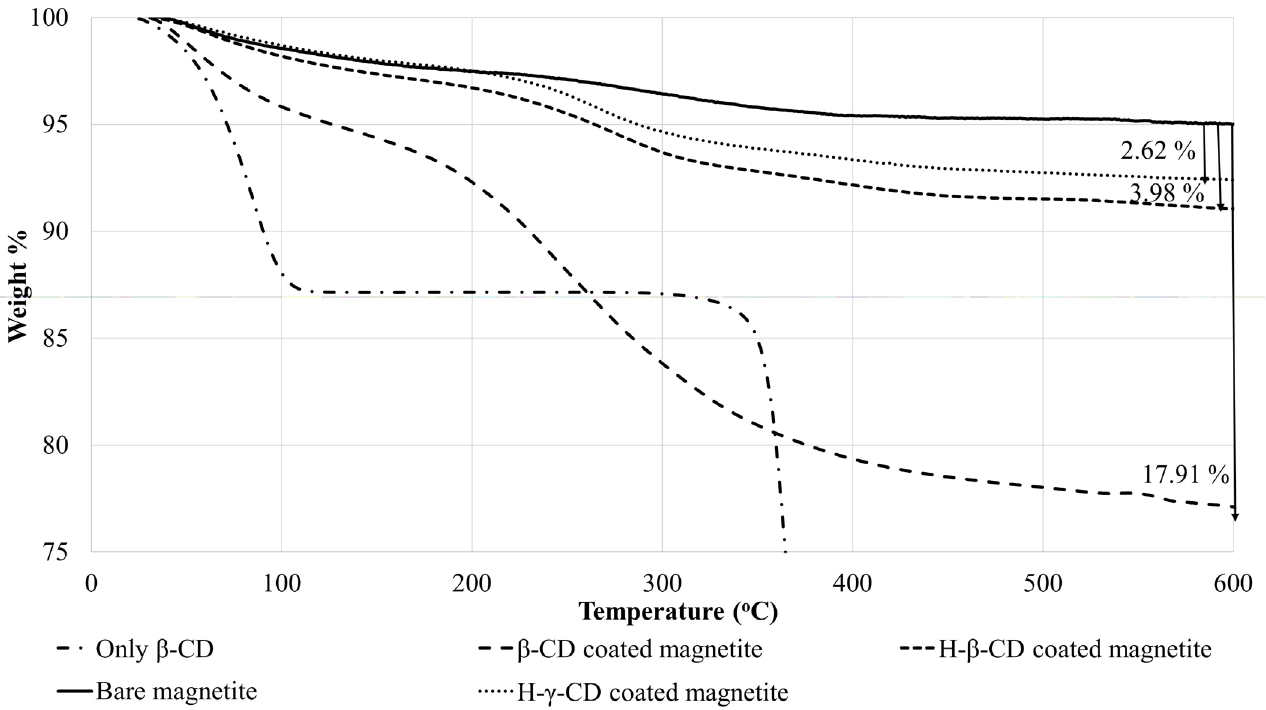
FIGURE 6 - Thermogravimetric analysis for magnetite with and without CD’s. The initial weight loss observed for all samples up to ~100 – 120 ºC are attributed to the removal of adsorbed water and further losses are due to the organic layer around the particles. The highest amount of CD coating is observed for b -CD coated magnetite nanoparticles (~18%) and the wt.% difference between the two plateaus at 150 ˚C and 600 ˚C are tabulated in Table I as % coating of magnetite nanoparticles with different type of